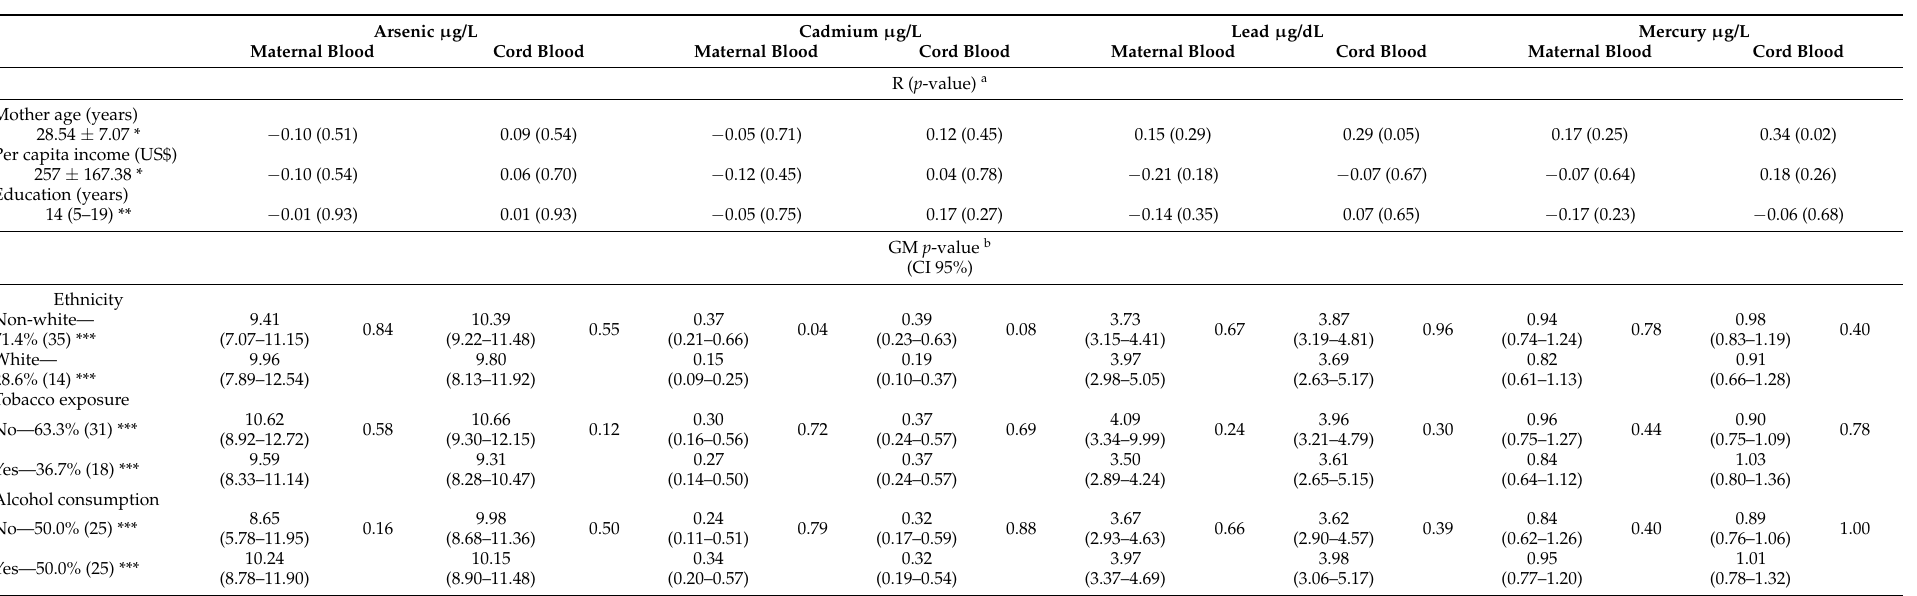
Table 2. Arsenic, cadmium, lead, and mercury concentrations in maternal blood and umbilical cord blood and maternal sociodemographic characteristics, Rio de Janeiro, Brazil,